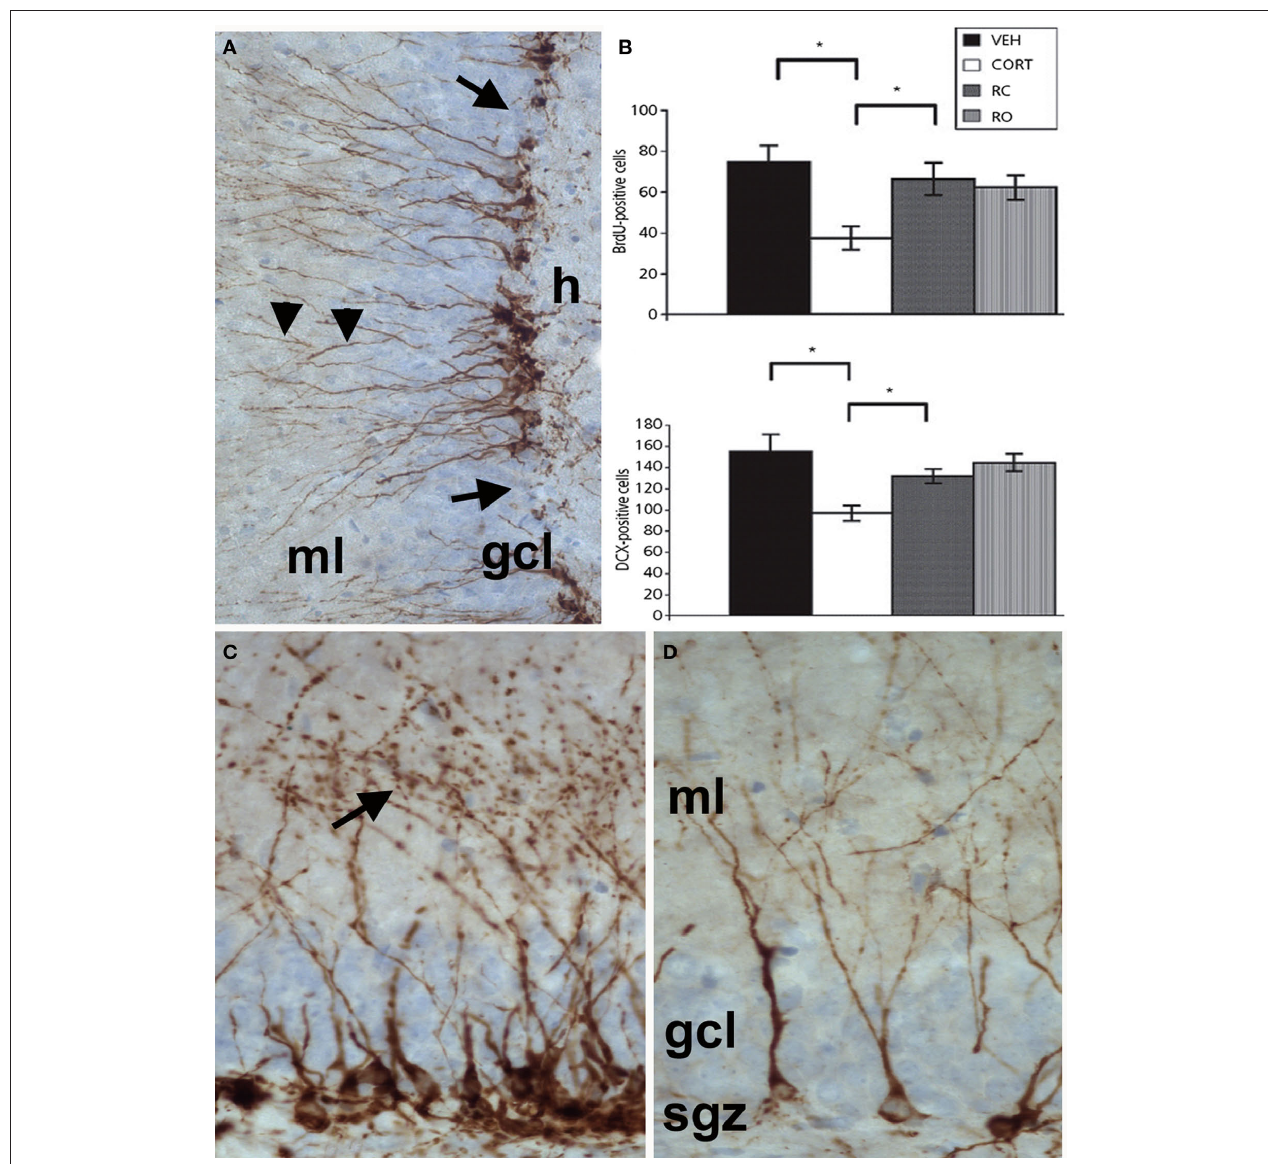
significant reduction in both BrdU- (21-day old cells) and DCX-positive cell numbers after 21 days of corticosterone treatment is normalized by mifepristone treatment for the last 4 days, whereas the drug alone has no effect. Black bars: control animals; white bars animals treated with corticosterone for 3 weeks; dark gray bars: animals treated with corticosterone and RU 38486; light gray bars: animals treated with RU 38486. (C + D) Details of the individual morphological patterns of DCX-positive new neurons in the hippocampus of control (C) and stressed animals (D) . Reproduced with permission from Mayer et al.